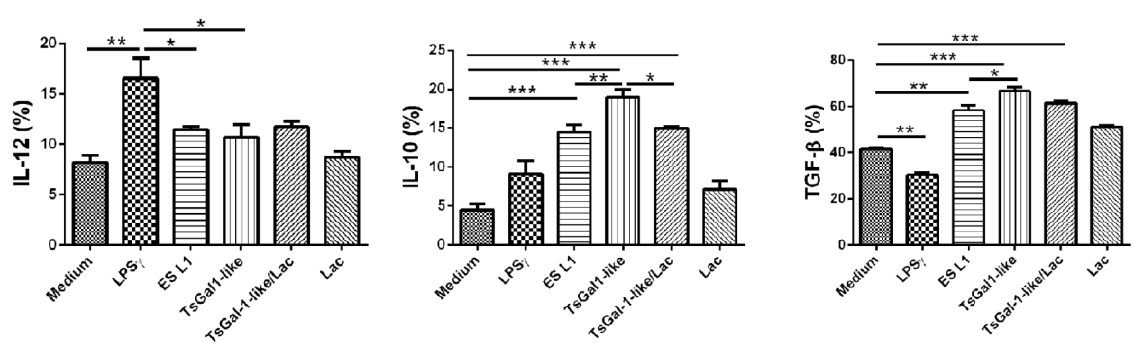
Figure 4: Cytokine expression of TsGal-1-like proteins-pulsed DCs . The summarized results of IL- 12p40/p70, IL-10, and transforming growth factor (TGF)-β expression are presented as mean value of percentage (%) of the expression ± SD from three different experiments. *p < 0.05, **p < 0.01, ***p < 0.005 compared as indicated (one-way ANOVA with Tukey’s